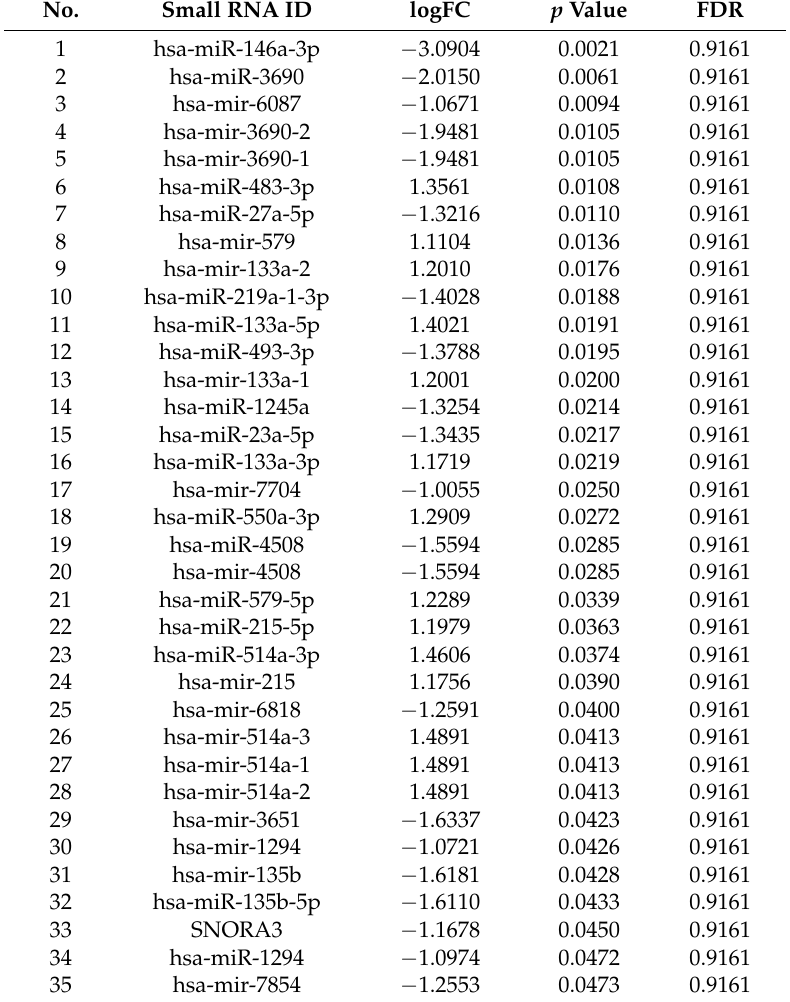
Table 6. List of small RNAs significantly differentially expressed in synovial tissue of patients with contrast pain phenotypes; raw p value < 0.05 and absolute log2 fold change (logFC) ≥ 1; FDR: false discovery